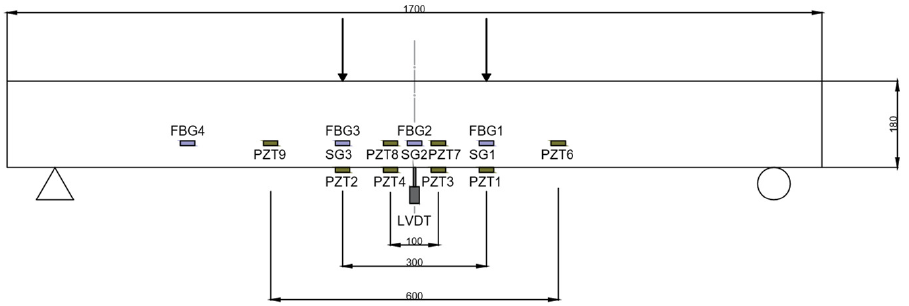
Figure 1. Test Figure 1. Test set-up.